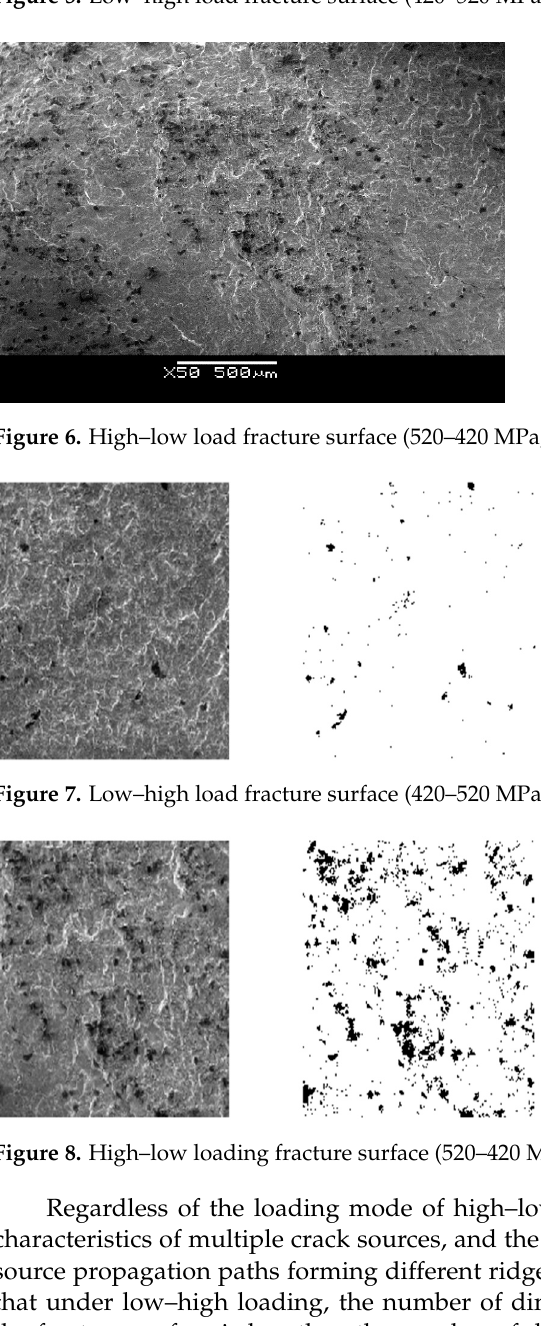
Figure 5. Low–high load fracture surface (420–520 MPa, n 1 /N 1 = 0.25).